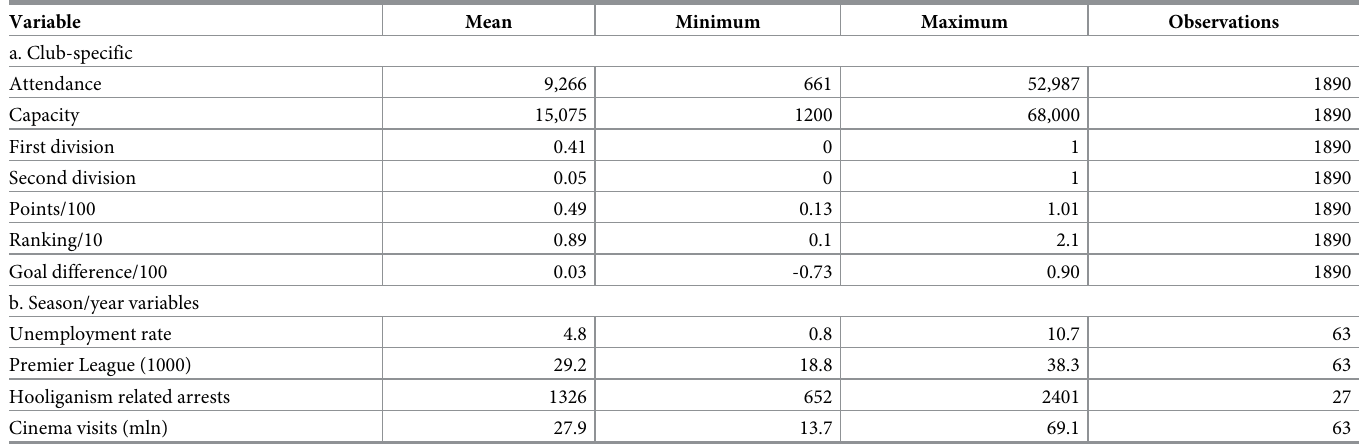
Table 3. Data descriptives;